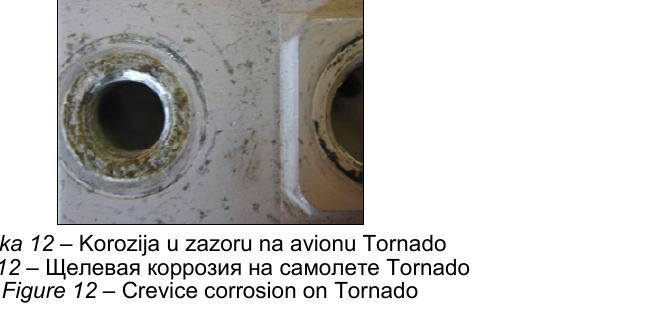
Figure 12 – Crevice corrosion on